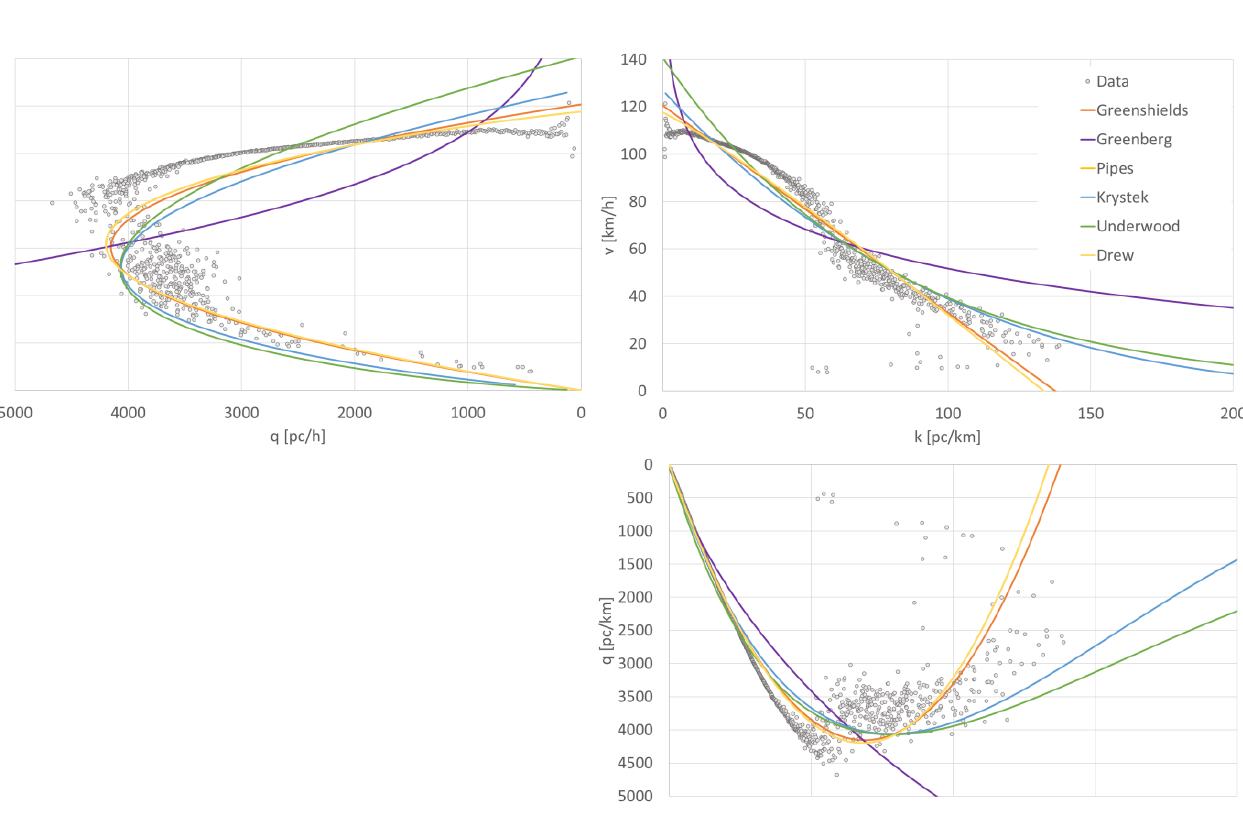
Figure 6. Fundamental diagram represented by single-regime models—group 1. Table 5. Assessment and comparison of traffic flow models for the field data.